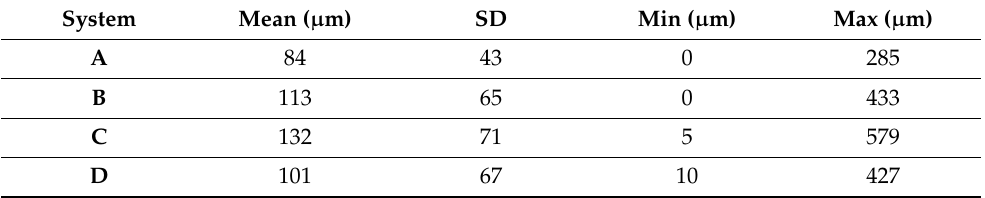
Table 1. Performance of the CAD/CAM